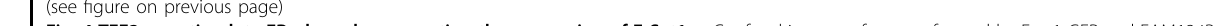
Fig. 4 TFE3 can stimulate ER-phagy by promoting the expression of E-Syt1. a Confocal images of puncta formed by Esyt1-GFP and FAM134B- mCherry colocalized in 786 O/OE-SR cells. Scale bar 20 µm and 5 µm. b Diagram of CCER assay. When ER-phagy occurs, the lysozyme cleaved the link between mCherry and RAMP4, and mCherry became a small molecule with only 27 KDa which been detected by WB. c HeLa and 786 O/OE-SR cells stably expressing CCER system were transfected with E-Syt1 and Western blot tested ER-phagy degree. d 786 O/OE-SR cells were transfected with sh- Esyt1 plasmid or empty plasmid and starved for 12 h by EBSS before WB measurement. e Western blotting of 786 O/OE-SR cells transfected with Esyt1 and treated with MG132 (10 μ M) or CQ (10 mM) for 12 h before harvest. f 786 O/OE-SR cells transfected with E-Syt1 were either in normal condition or in EBSS with or without 3-MA (500 nM), Baf -A1 (100nM) for 12 h and harvested for WB. g 786 O/OE-SR cells were transfected with E-Syt1 and sh- FAM134B or one of the plasmids. Then cells were cultured in normal condition or in EBSS for 12 h. The result was shown by WB. h Schematic diagram of the EATR assay. When ER-phagy occurs, green fl uorescence quenched in acid lysosome leaving only the red fl uorescence excited by mCherry. i Confocal images of 786 O/OE-SR cells (stabling expressing EATR system) transfected with E-Syt1 fi xed to visualize ER-phagy. Scale bar 20 µm